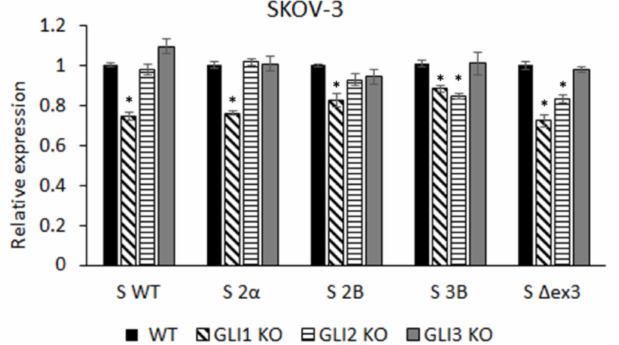
Figure 2. Levels of survivin isoform expression in the SKOV-3 GLI KO lines compared with SKOV-3 WT cells. * represents statistically significant downregulation in comparison with the WT cell line ( p <